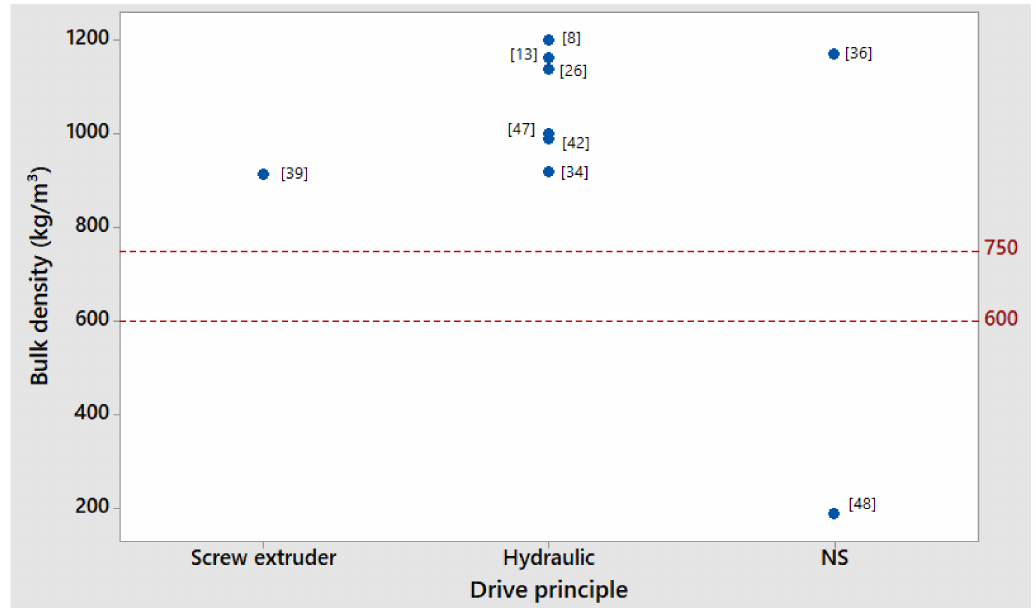
Figure 8. Relationship between individual values of bulk density and the principle of operation of briquetting